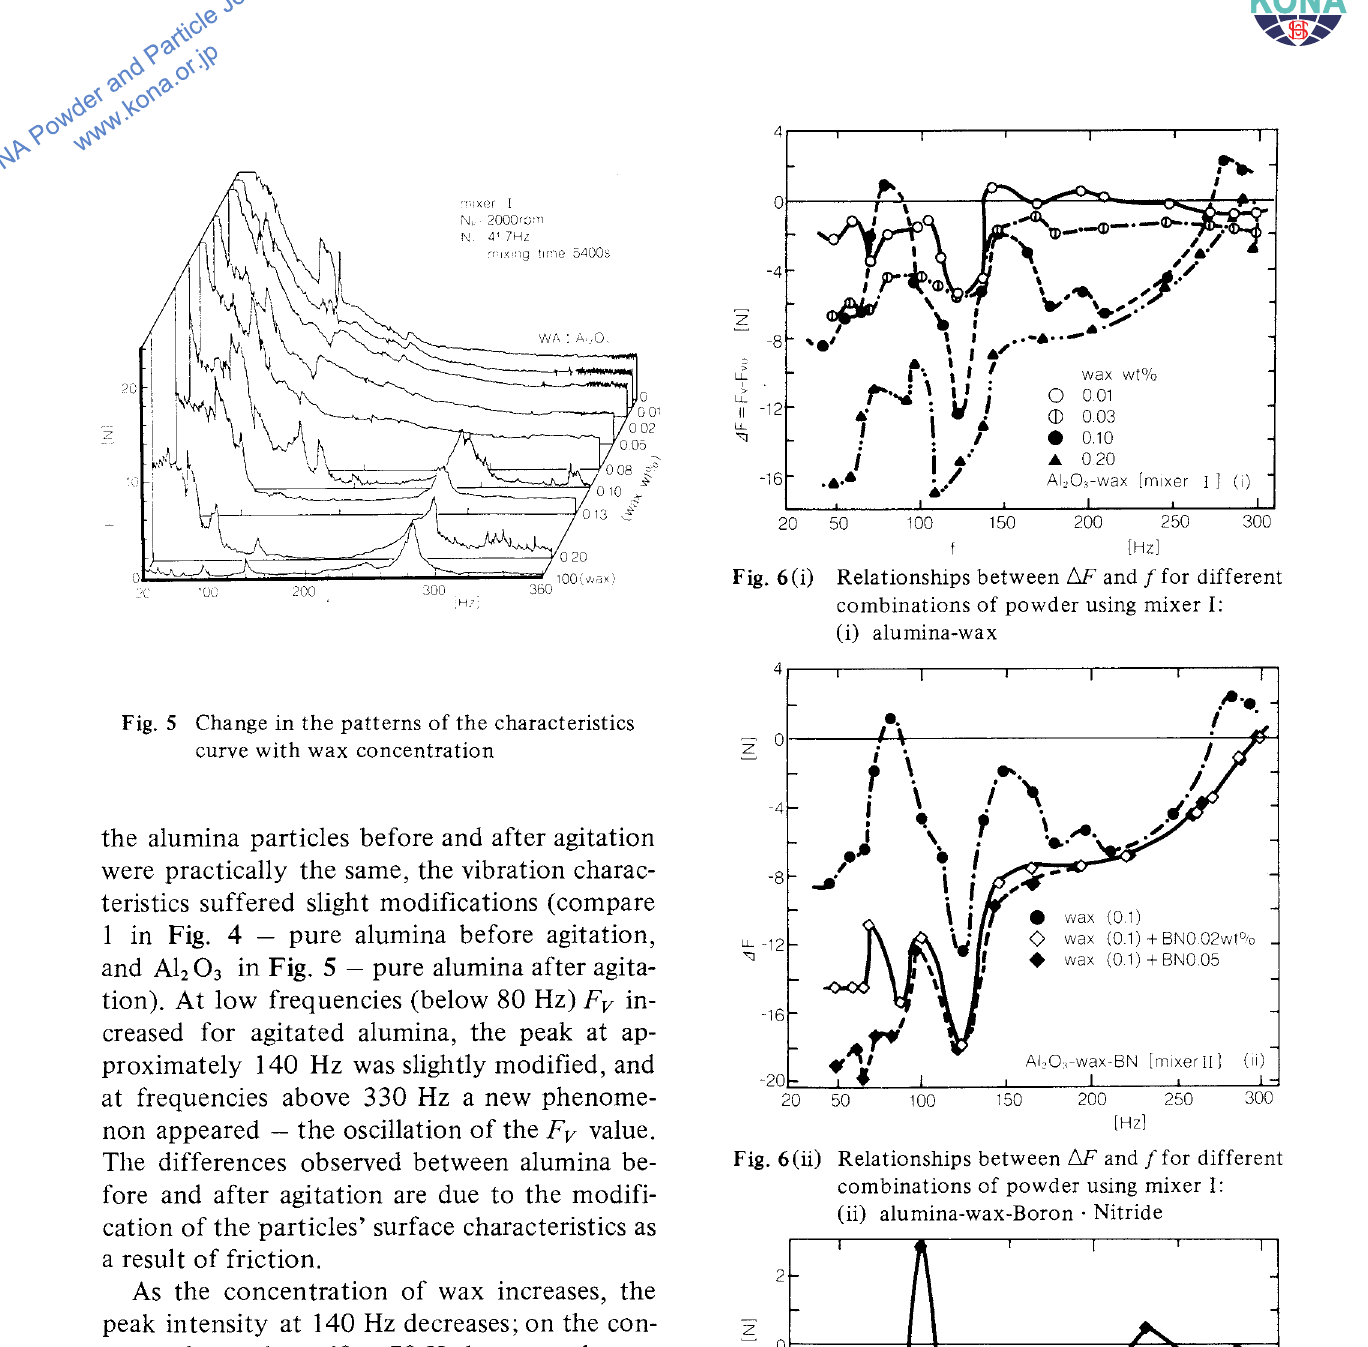
Fig. 5 Change in the patterns of the characteristics curve with wax concentration